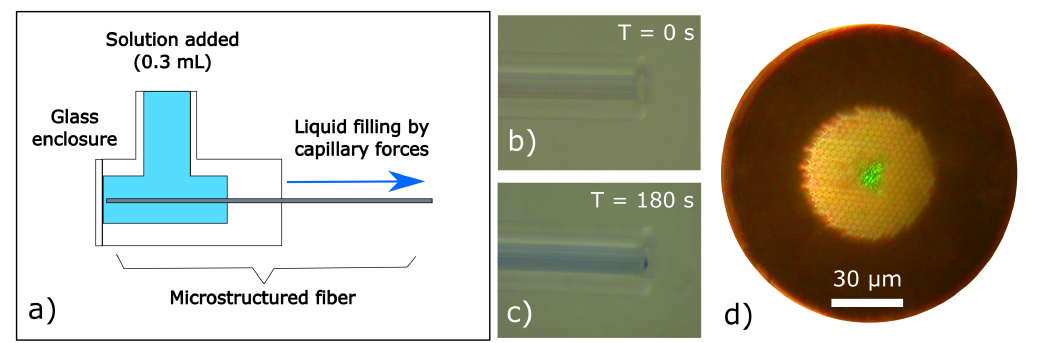
Figure 2. Fiber filling experiments: ( a ) schematic of sample loading into a prepared fiber that is encased in a glass enclosure. ( b , c ) Microscope images showing the loading of blue ink into the fiber, at the start ( b ) and at the end ( c ) of the process. ( d ) Microscope image showing the transmission of green laser light in the filled fiber core. The image is taken from a cleaved end of the fiber after sample loading. The fiber outer diameter is 125 µm with a fiber core diameter of 10 µm and a diameter of 50 µm for the holey region.